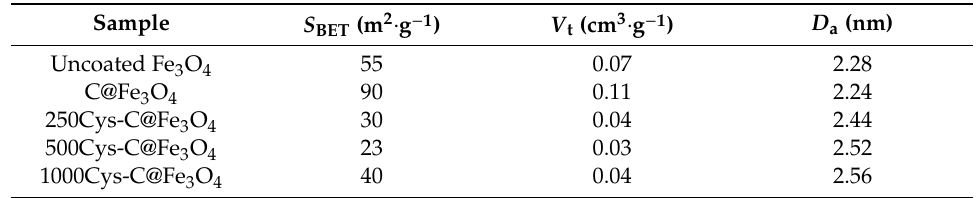
Table 1. Porous structural data for as-synthesized samples ( S BET , specific surface area by BET; V t , total pore volume; D a , average pore